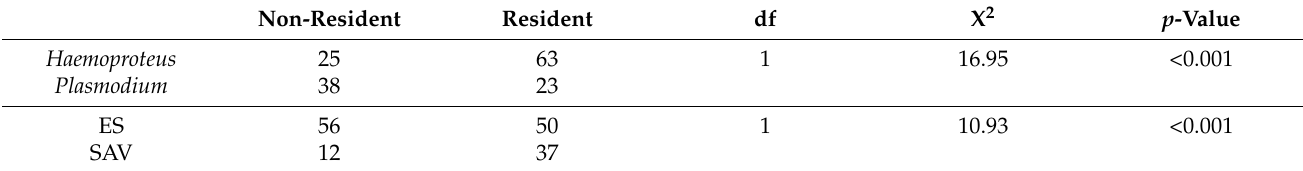
Table 5. Chi-squared tests of independence between non-resident and resident birds by parasite genus and sampling site. See Table 6 for categorizations of each species by migratory or year-round status.